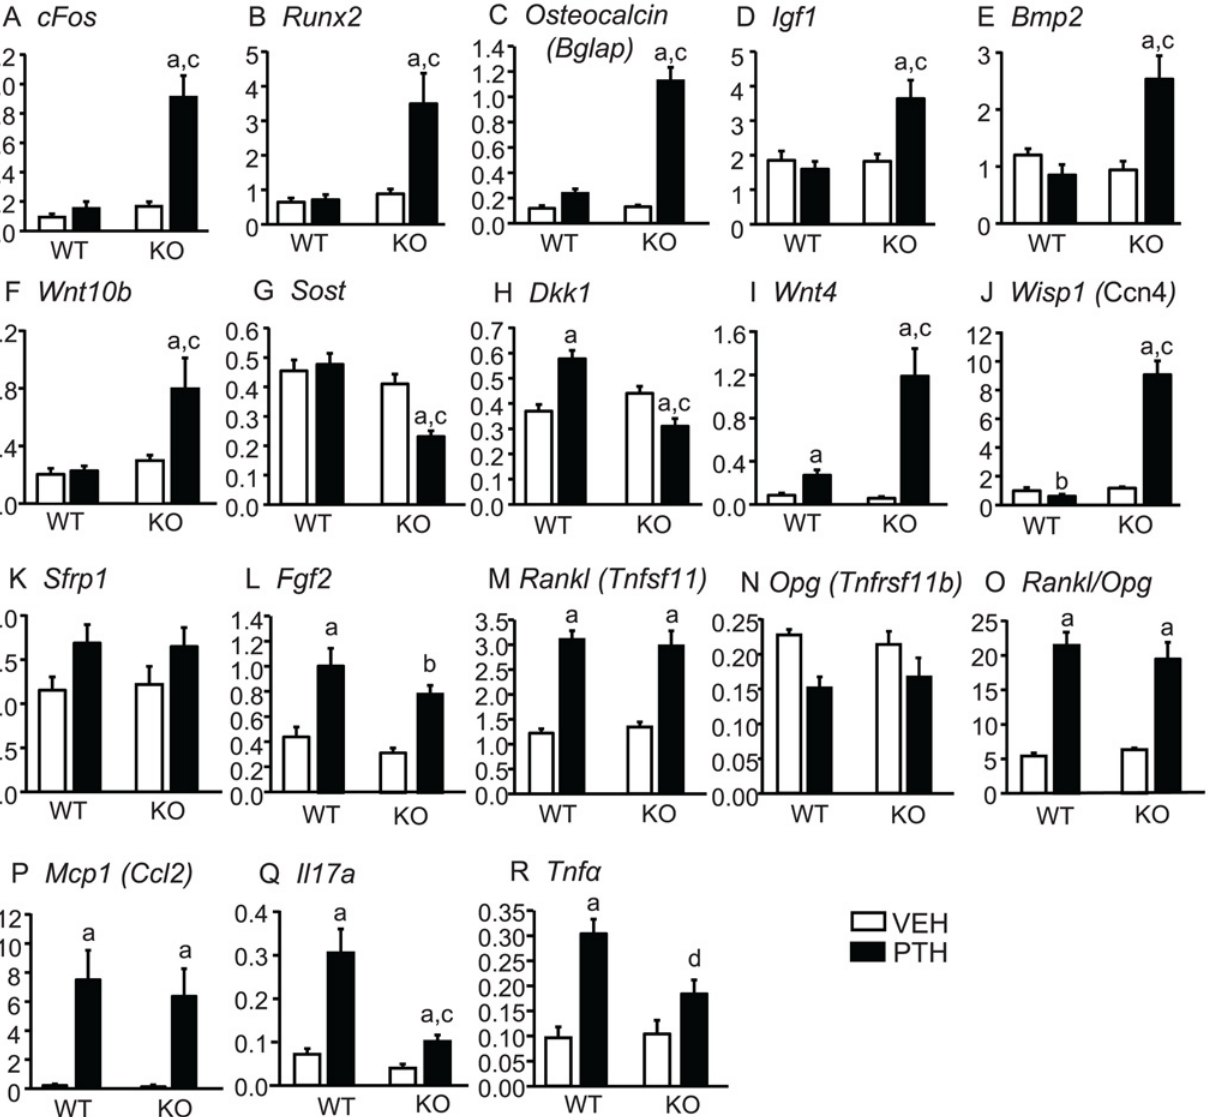
Fig 7. Tibial gene expression in mice infused with vehicle or PTH for 21 days. At the end of infusion, both tibiae were combined for RNA extraction and mRNA expression was measured by qPCR Bars are means ± SEM for 6 WT and 6 KO mice infused with vehicle and 7 WT and 7 KO infused with PTH. a Significant effect of PTH, p < 0.01; b p < 0.05. c Significant effect of genotype, p < 0.01; d p <